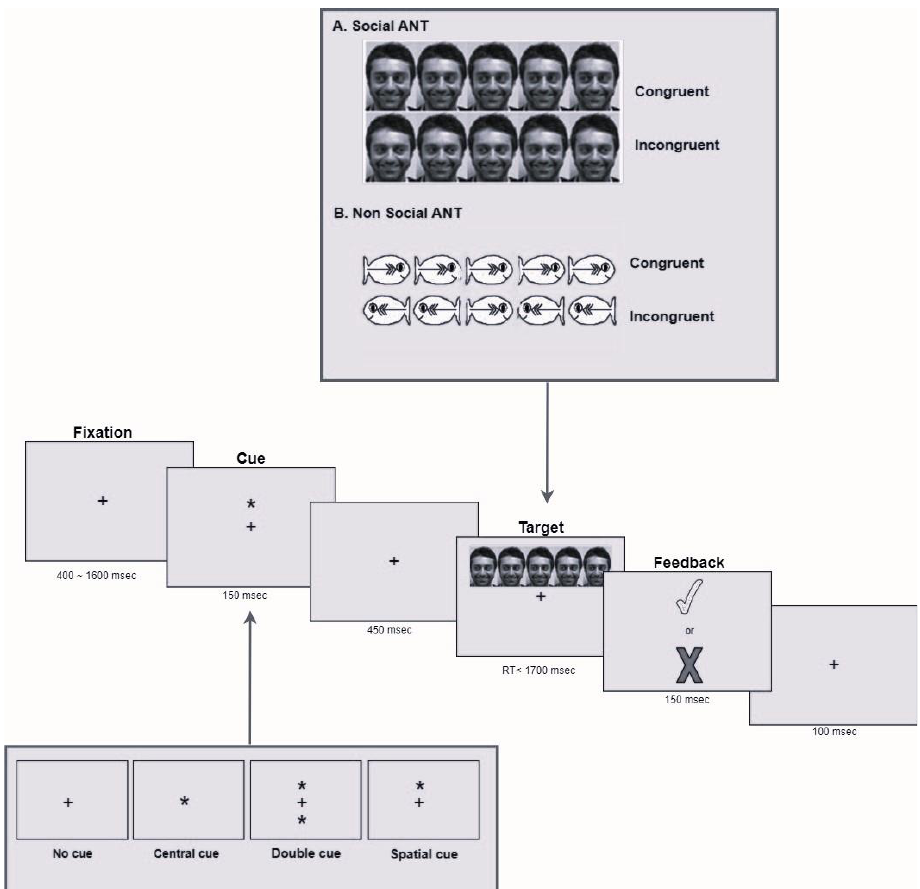
Figure 1. Detailed illustration of the modified version of the Attention Network Test (ANT). Modi- fied version of Figure 1 in Federico and collaborators ’ [22]. += fixation cross; *= cue (central, double or spatial). Target stimulus and response feedback are